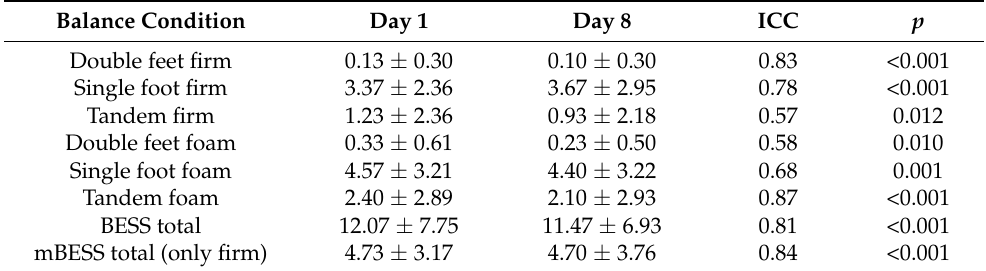
Figure 6. BESS score for day 1 and day 8. Table 4. The statistical results of system score on the first and eighth day as well as the ICC value of each condition.